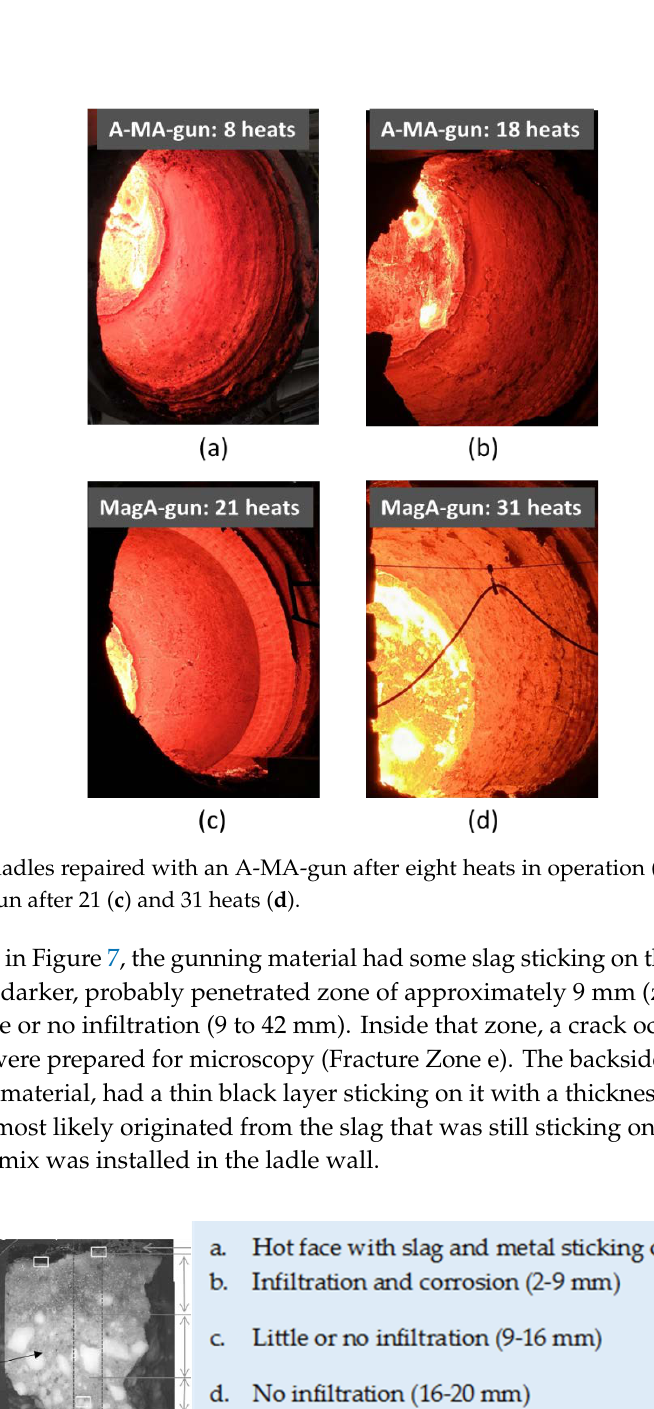
7 Table 4. Chemical composition of ladle slag (wt%). CaO 1 Figure 5. A-MA castables with slag treatment at 1600 °C, 3 h. 3.2. Verification of Laboratory Findings in the Industrial Ladle Trial In order to verify that the porous MagA could withstand real steel ladle conditions, a trial was conducted using an alumina spinel dry-gunning repair mix as a reference (A-MA-gun) in comparison to a dry-gunning mix (MagA-gun) in which about half of the amount of the dense alumina aggregates was replaced by the porous MagA. Both gunning mixes were applied on a used and cold alumina spinel